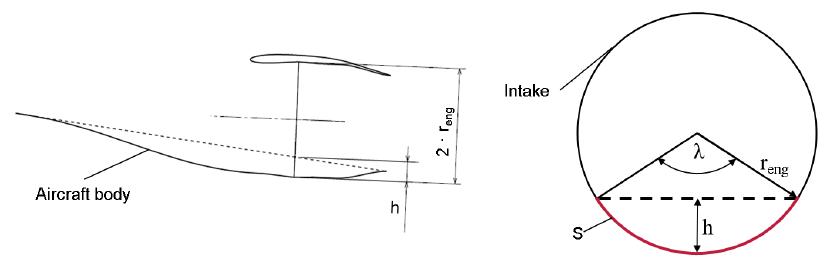
Figure 13. Side view of an embedded engine ( left ) and front view of the engine substitution model ( right